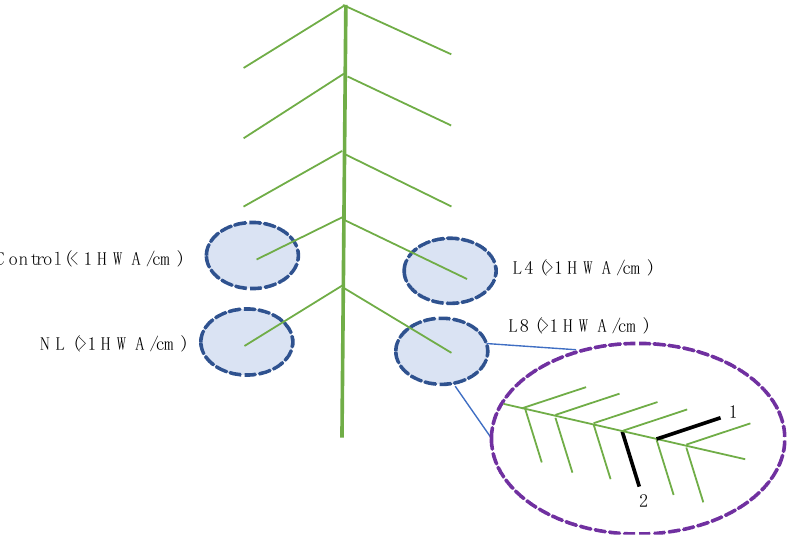
Figure 1. Tree set-up diagram. Green lines represent an example of an eastern hemlock tree with branches selected for the study. Small blue dotted circles represent mesh cages applied over treatment branches. Each cage was assigned one of four treatments: Control, NL, L4, or L8. The control branches had an HWA density < 1 HWA/cm, the other three treatments had an HWA density > 1 HWA/cm. The large purple circle represents a close up of a treatment branch. Bold black lines represent branchlets off of the main branch that were selected for experiment 1 and 2.